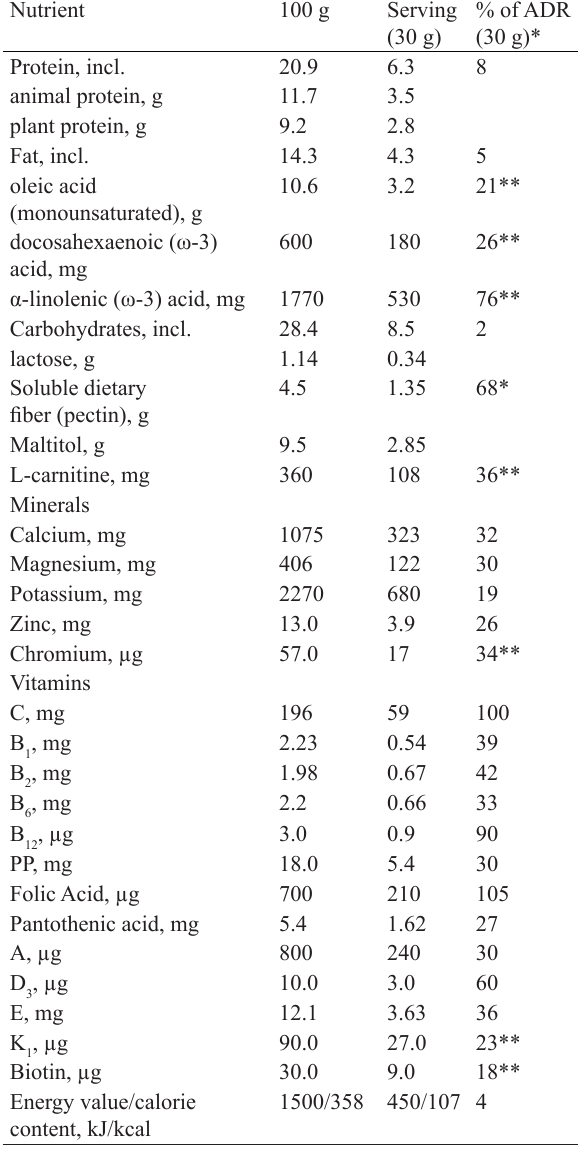
Table 1 Contents of specialized food nutrients per 100 g, one serving and % of the average daily requirement (ADR) Nutrient 100